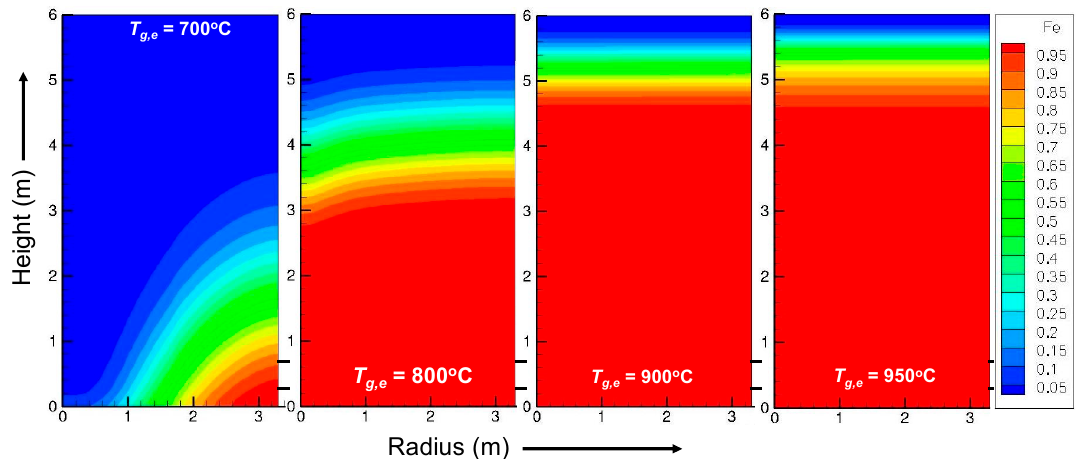
Figure 4. Calculated influence of the inlet gas temperature on the iron mass fraction.